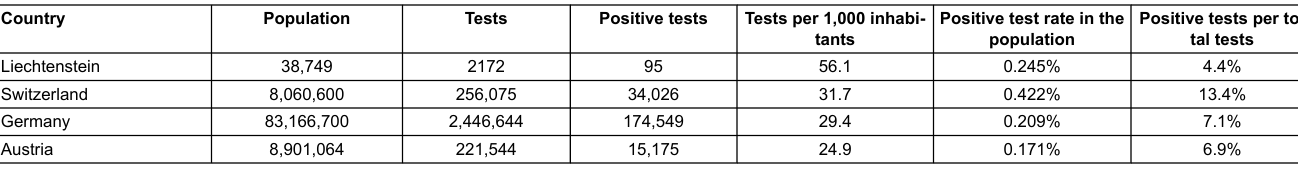
Table 2: Testing rates in four German-speaking countries as of 26 April 2020 [34–37]. Country